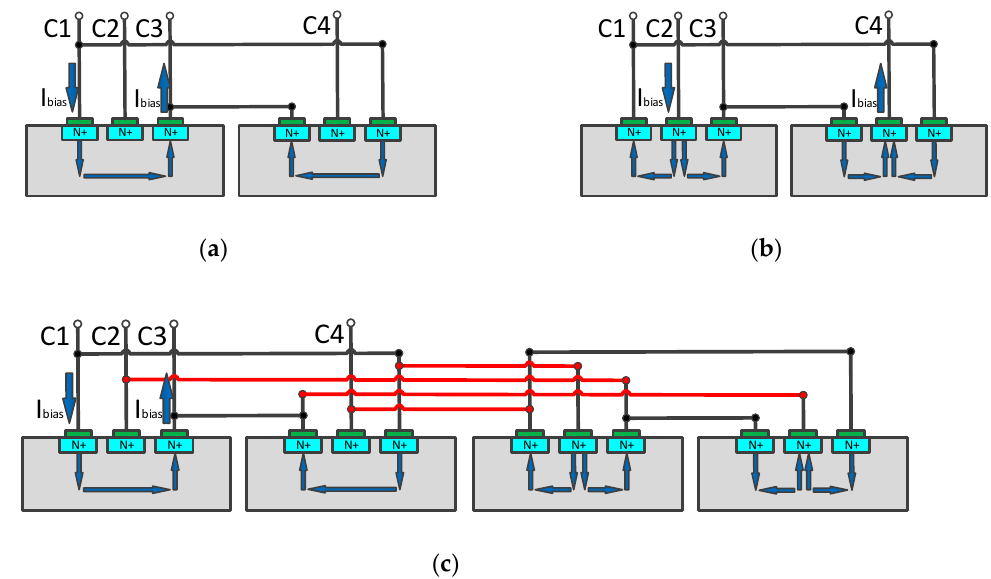
Figure 1. The current flow path: ( a ) the double three-contact vertical Hall device in the phase 0; ( b ) the double three-contact vertical Hall device in the phase 90; ( c ) the orthogonal coupling structure in the phase 0.